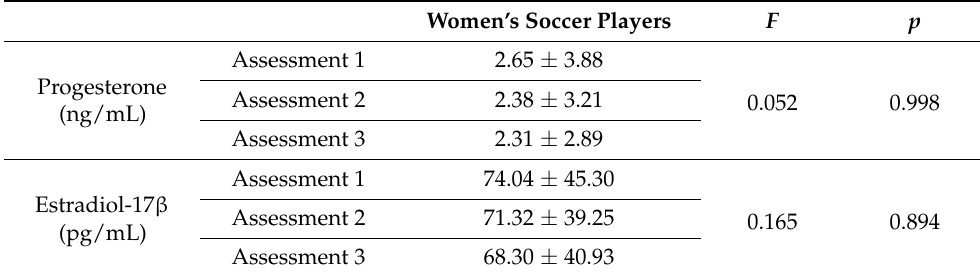
Table 5. Concentration of female hormones.